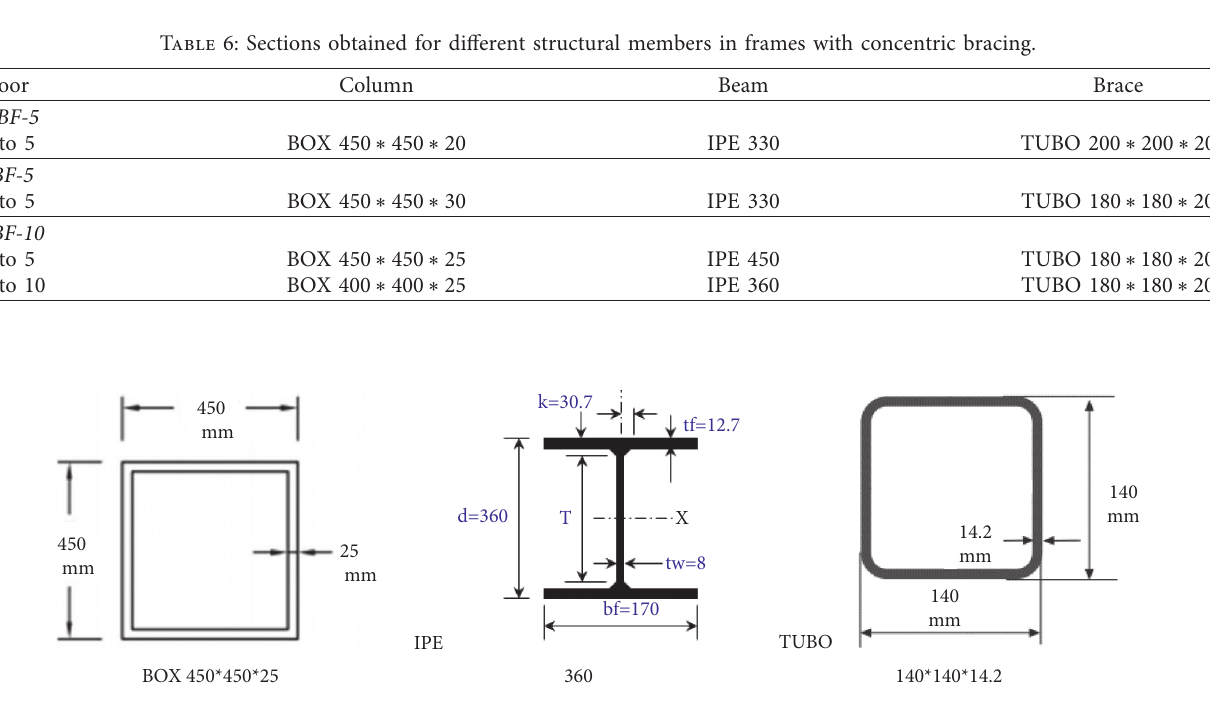
Figure 10: An example of each section type that used in concentric bracing